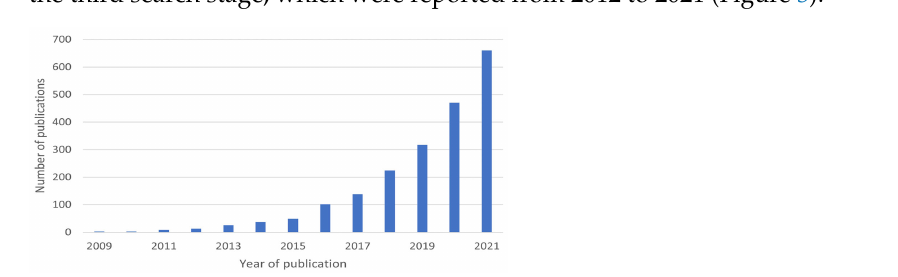
Figure 2. Documents published from 1970 to 2021 under the search criterion [TITLE ‐ ABS ‐ KEY (“ad ‐ vanced” AND “oxidation” AND “processes” AND “wastewater”)]. Figure 3. Documents published from 2012 to 2021 under the search criterion [TITLE ‐ ABS ‐ KEY (“bi ‐ ochar” AND “advanced” AND “oxidation” AND “process”)]. The central theme of the current work is the coupling of biochar and AOPs for the removal of dyes in wastewater. Therefore, the documents found from the search string related to the keywords [TITLE ‐ ABS ‐ KEY (“biochar” AND “advanced” AND “oxidation”